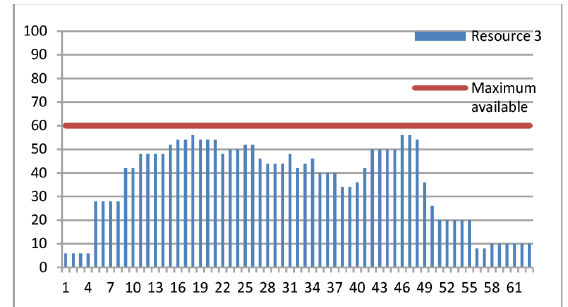
Figure 48. Daily usage of resource 2 throughout the calendar of the project (before using the method)-Experiment 3